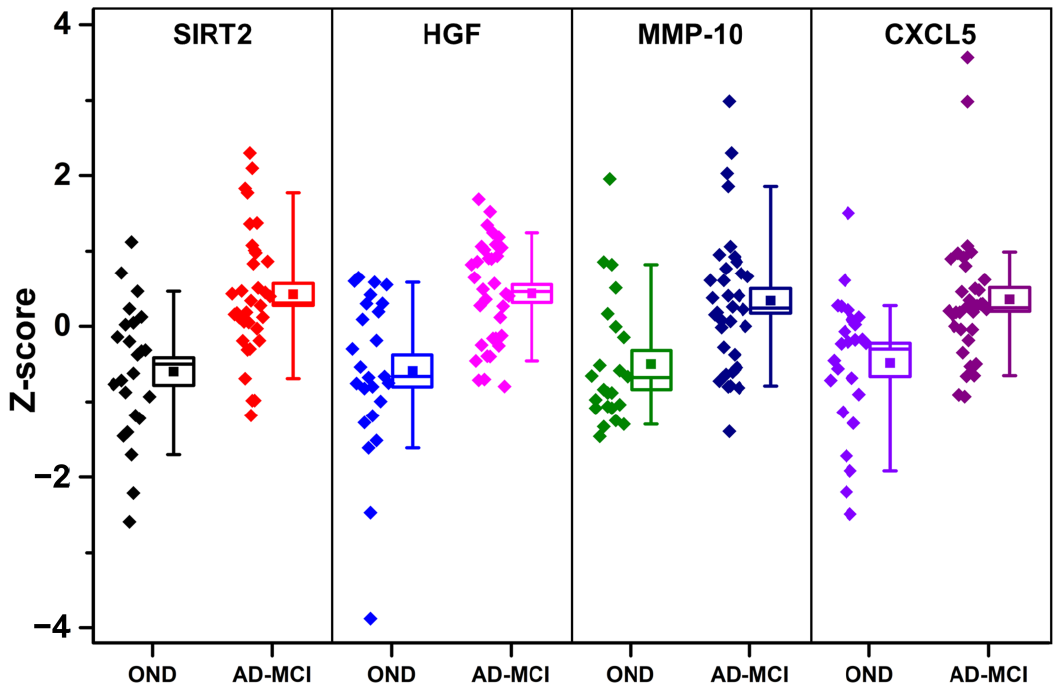
Figure 3. Distribution of SIRT2, HGF, MMP-10, and CXCL5 z-scores in OND and AD-MCI groups. Boxes representing data distributions are centered on the mean values, with the internal horizontal line representing the median. Box heights are equal to the standard error of mean values, whiskers represent the 10–90% data range. For abbreviations of PEA-tested proteins, see Table S1.